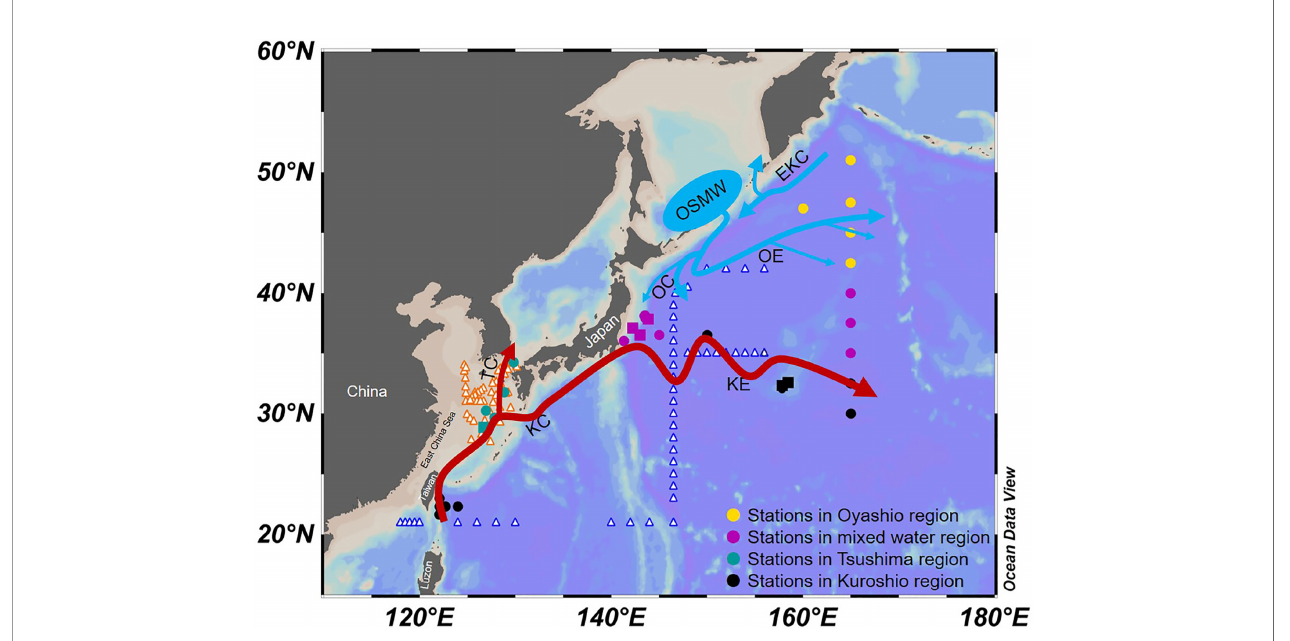
FIGURE 1 | Oceanographic setting of the Northwest Paci fi c region and sampling locations in this and previous studies. Stations from this study are indicated by solid symbols (solid square: sampled only at surface; solid circle: sampled at both surface and DCM), and those from previous studies discussed are indicated by un fi lled triangles [ ▵ are from Bi et al. (2018); ▵ are from Lin et al. (2020)]. KC, Kuroshio Current; KE, Kuroshio Extension; TC, Tsushima Current; OC, Oyashio Current; OE, Oyashio Extension; OSMW, Okhotsk Sea Mode Water; EKC, East Kamchatka Current. The current map is adapted from Yang et al. (2018) and Qiu